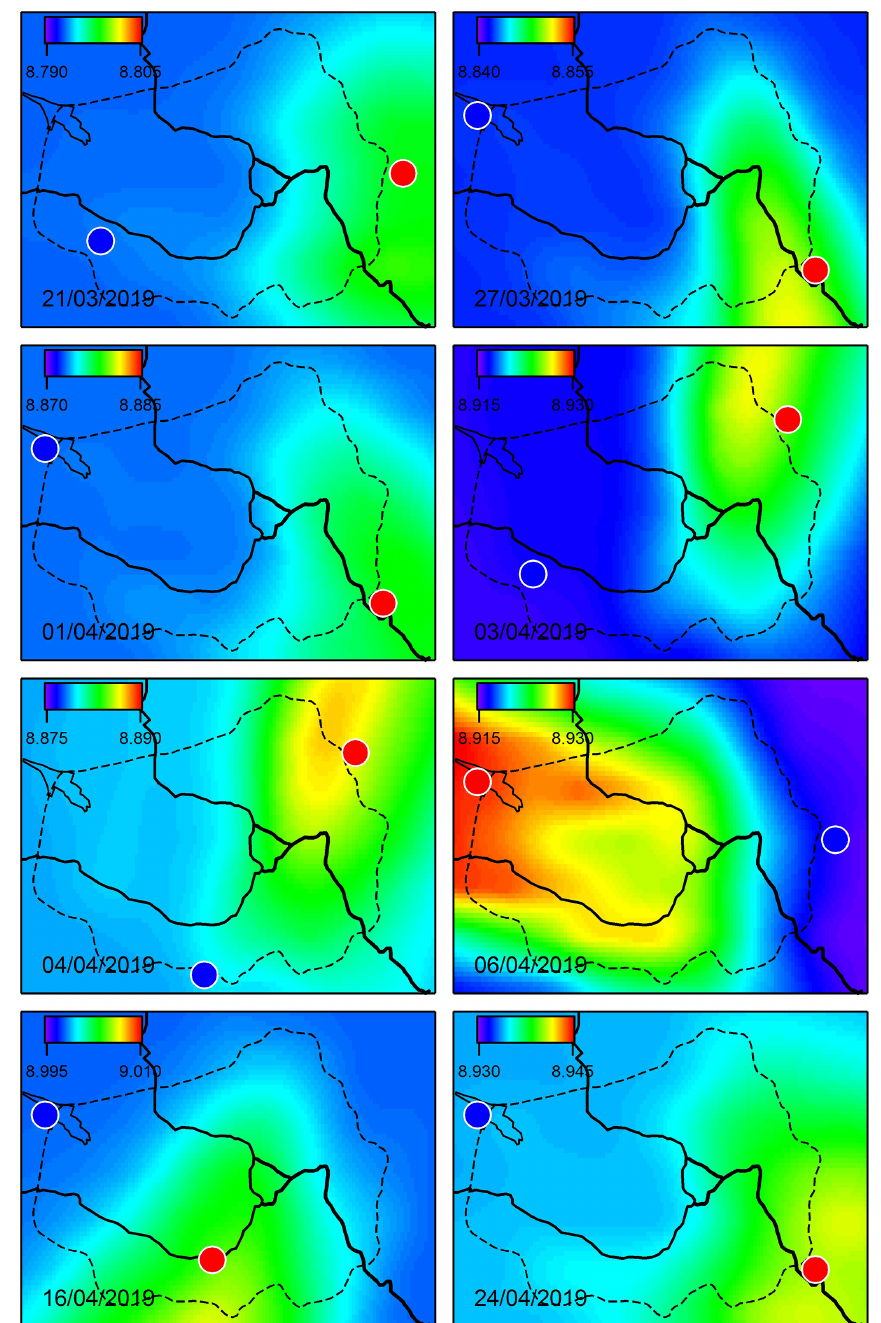
Figure A1. Urban pollution CO 2 plume over St Petersburg calculated with HYSPLIT model for the days of field campaign in 2019 (10:00UTC). The colour bar units for TC CO are 10 21 cm − 2 . The blue and red circles indicate the locations of upwind and downwind 2 FTS observations,